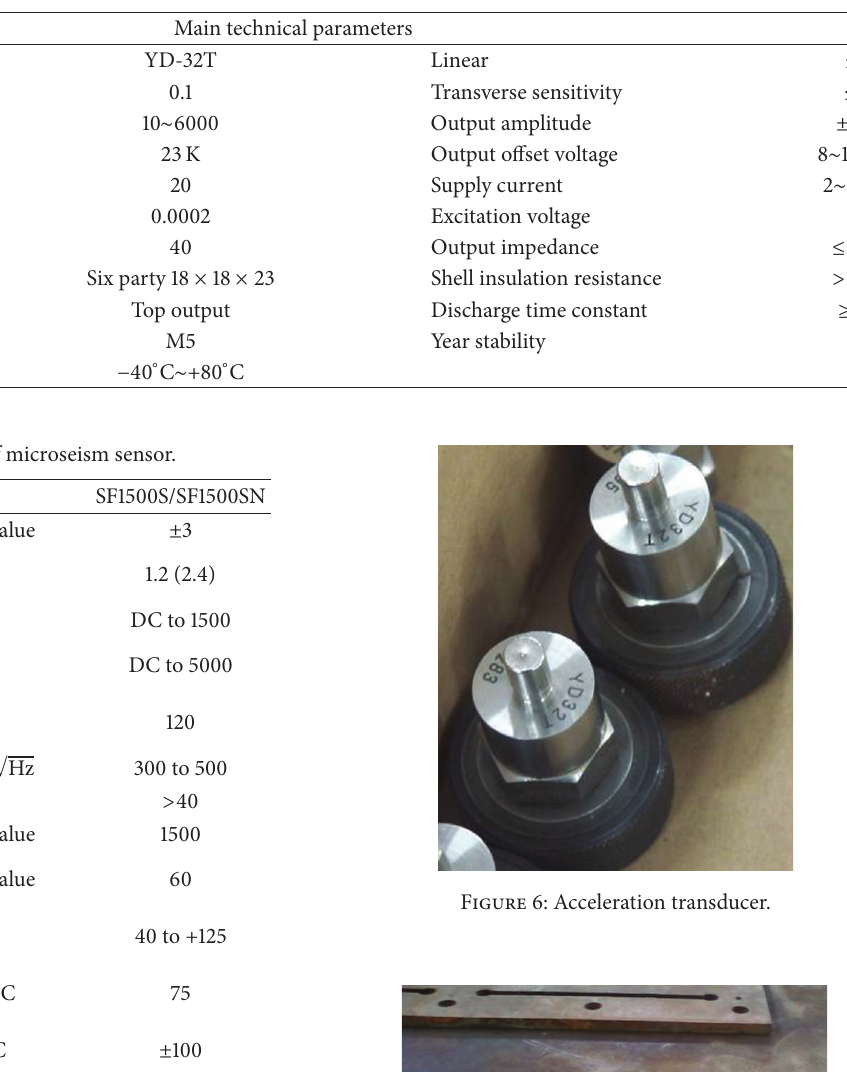
Table 3: Technical data of the acceleration sensor.